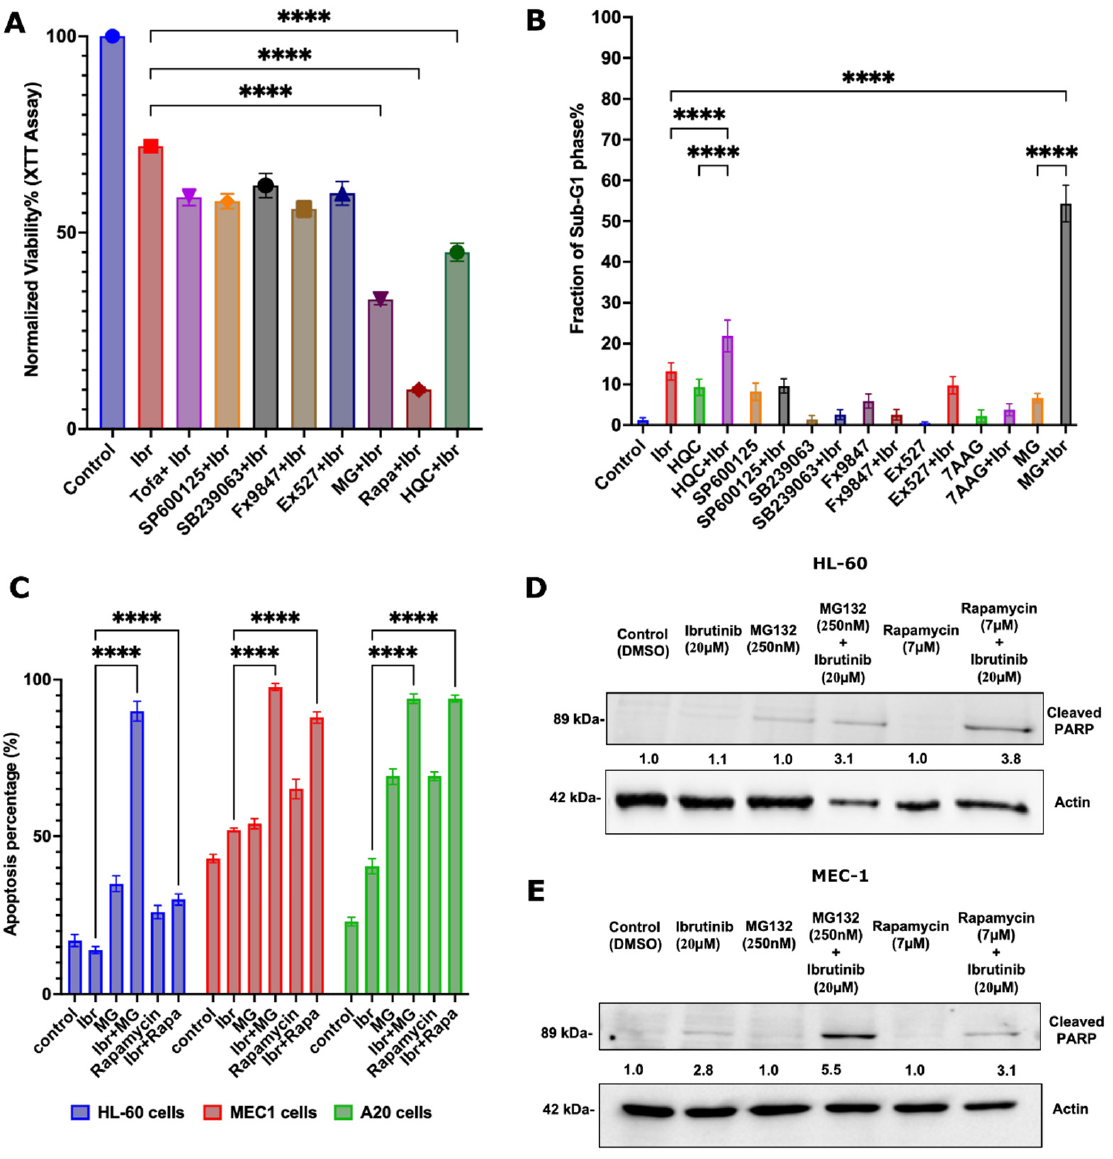
Figure 1. Synergy tests in vitro with HL-60, MEC1, and A20 cells. ( A ). Effects of drugs on ibrutinib sensitivity of HL-60 cells tested by XTT. Cells were incubated with 15 µ M ibrutinib alone or combined with subtoxic concentrations of listed inhibitors for 24 h. The experiment was performed in biological replicates ( n = 4), ( B ) . Effects of drugs on ibrutinib sensitivity of HL ‐ 60 cells tested by FACS analysis (sub ‐ G1 population). The experiment was performed in biological triplicates (n = 3), ( C ). Effects of the combination of ibrutinib with MG132 and ibrutinib with rapamycin on cell viabil ‐ ity (HL ‐ 60, MEC ‐ 1, and A20) measured by annexin V apoptosis assay performed in biological trip ‐ licates ( n = 3). ( D ). Effects of the combination of ibrutinib with MG132 and Ibrutinib with rapamycin tested by PARP cleavage. HL ‐ 60 and ( E ) MEC1 cells were incubated with drugs for 24 h. The exper ‐ iment was performed in biological triplicates ( n = 3) for all the above experiments. PARP cleavage was assessed by immunoblotting. Statistical analysis was performed using two ‐ way ANOVA. All statistical analysis was performed using Graphpad (v9), level of significance was taken as (“ns” = 0.1391, **** “ p < 0.0001”) as denoted appropriately on the above graphs. 3.4. Synergistic Effects of the Proteasome Inhibitor Bortezomib and Ibrutinib in the Mouse CLL Model Further, we tested a combination of ibrutinib with the FDA ‐ approved proteasome inhibitor bortezomib in the xenograft CLL model. Briefly, BALB/c mice were IV injected with 5 × 10 5 A20 cells expressing Luc ‐ mCherry. When the fraction of mCherry ‐ labeled cells in the blood reached 6–8%, we started the treatments, as described in Materials and Methods. We had four groups of mice, including (1) a nontreated control group, (2) an ibrutinib ‐ treated group (daily 9 mg/kg), (3) a bortezomib ‐ treated group (0.5 mg/kg twice a week), and (4) a combination group treated with ibrutinib 9 mg/kg daily and bortezomib